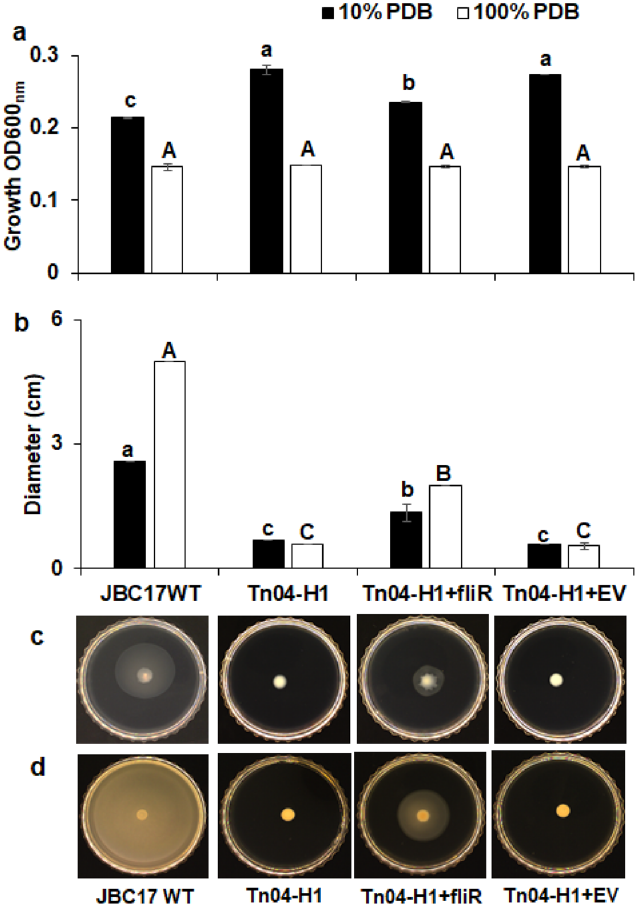
Figure 9. Complementation of fliR gene into Tn mutant strain Tn04-H1 of Pseudomonas putida JBC17. The gene was cloned into pUCP18 Cat and transformed into the fliR mutant strain (Tn04-H1) to produce the complemented strain (Tn04-H1 + fliR ). An empty vector (EV) was also transformed into the mutant to produce a control strain (Tn04-H1 + EV). ( a ) In vitro growth in 10% and 100% PDB; ( b ) Swimming motility in ( c ) nutrient-poor 10% PDA and ( d ) nutrient-rich 100% PDA containing 0.3% agar. Vertical bars indicate the mean ± SD of the replications. Bars with the same letters are not significantly different at P < 0.05 according to Tukey’s